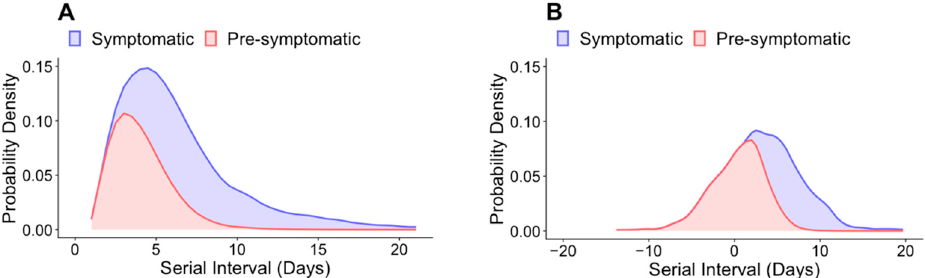
Figure 3. Estimated attribution of the serial interval into pre-symptomatic transmission and symp- tomatic transmission for ( A ) Period 1 and ( B ) Period 2. These estimates assume that there is no cor- relation between the incubation period and serial interval estimates.